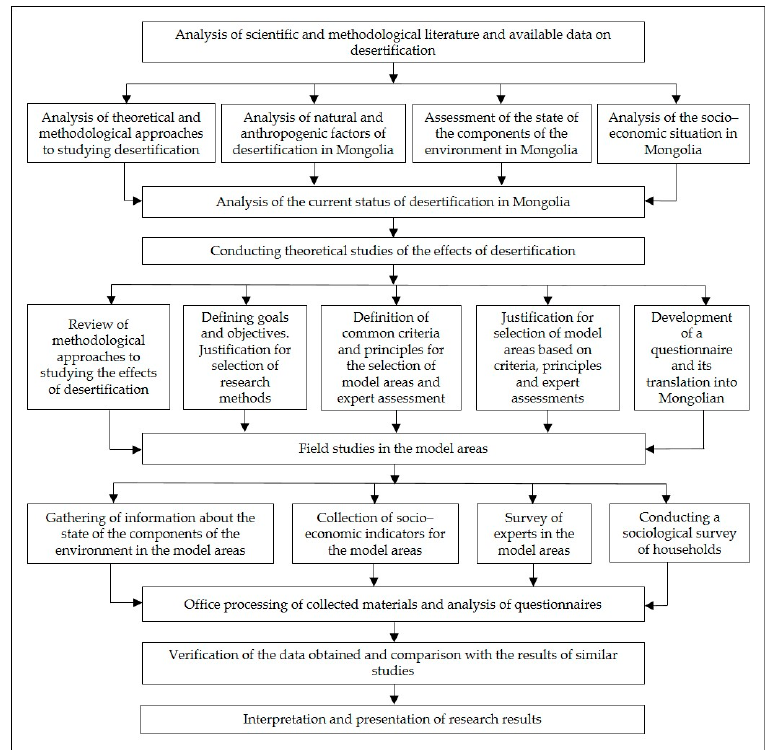
Figure 2. Research methodology.